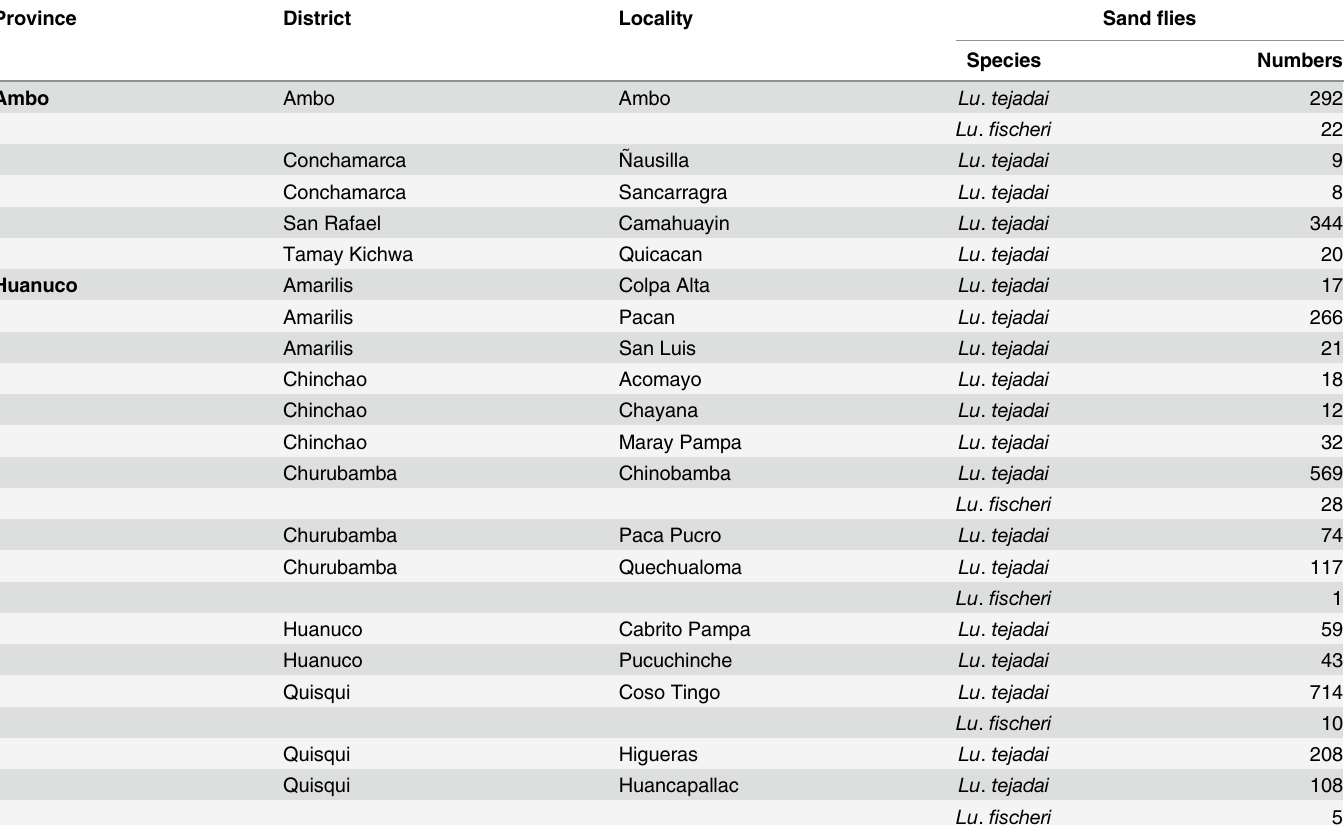
Table 1. Sand fly collection in Department of Huanuco.